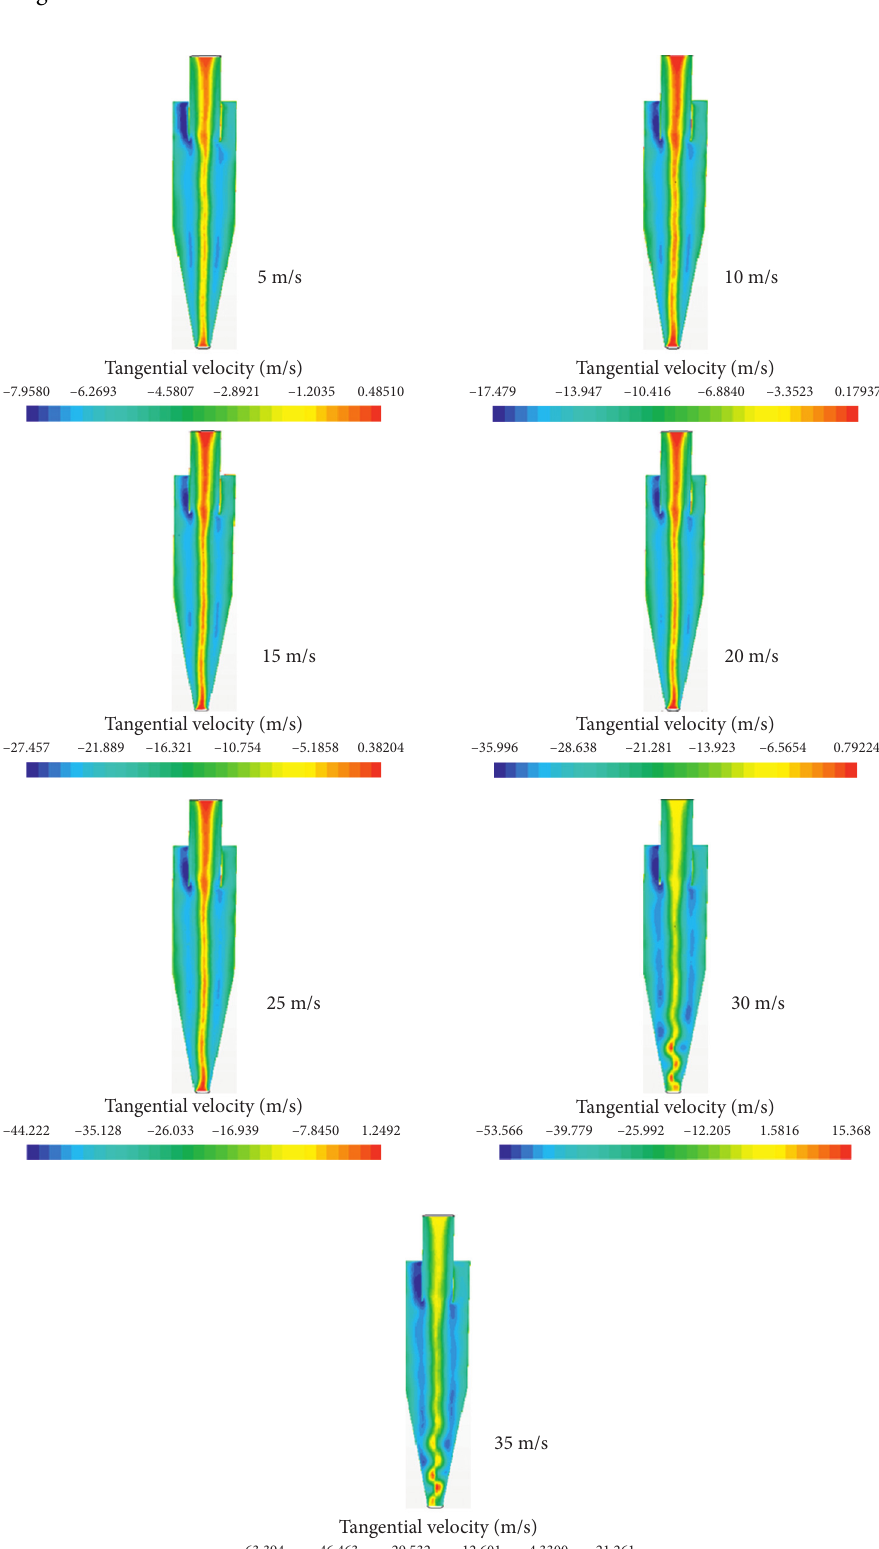
Figure 5: Tangential velocity contours at different inlet